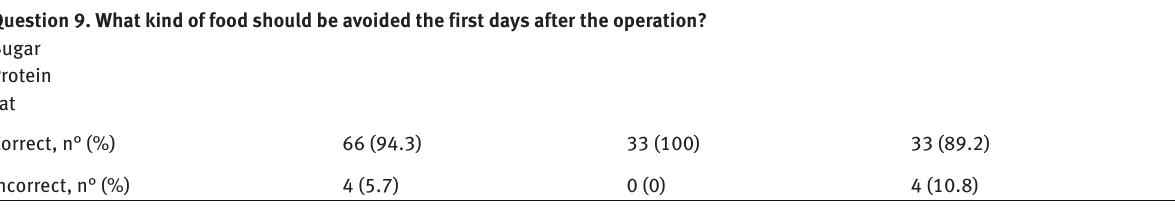
Table 2: Feedback questionnaire items and number and percentage of patients who responded correctly or incorrectly.